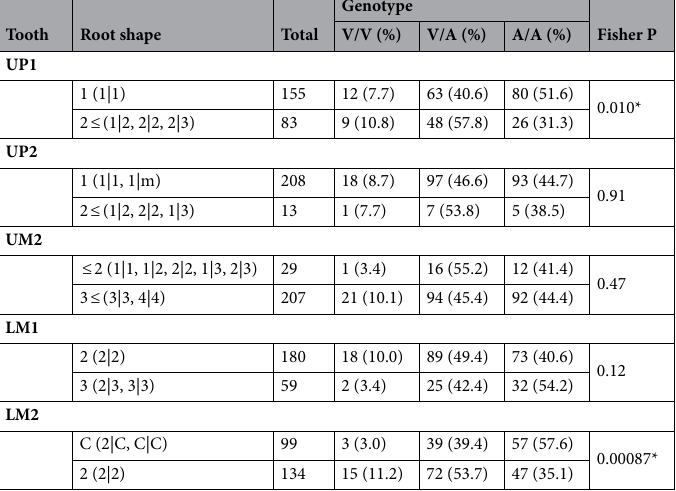
Table 1. The EDAR 370V/A genotype and root morphology. Root shape for each individual is indicated as a combination of both sides. 1: single root, 2: two roots, 3: three roots, 4: four roots, m: congenital missing, C: C-shaped root. *Significant association (P < 0.05).